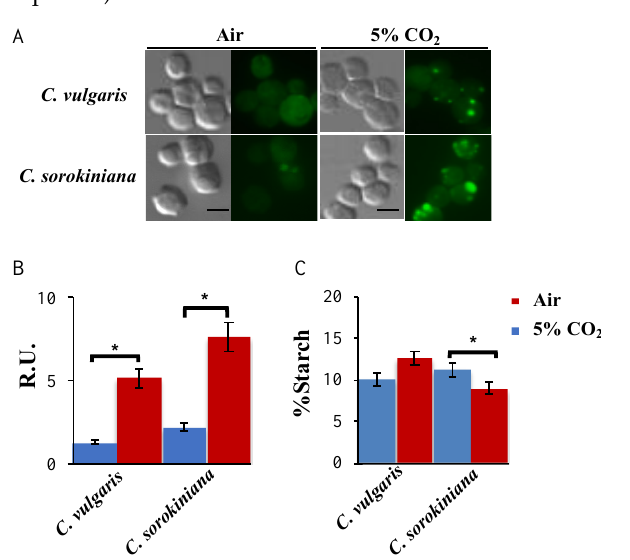
Figure 3. Carbon storage distribution in Chlorella strains: ( A ) Lipid bodies were stained with Nile red and imaged by differential interference contrast (DIC) and fluorescence microscopy in the C. sorokiniana and C. vulgaris either in air or 5% CO 2 . Scale bar = 8 mm. ( B ) Quantification of Nile red fluorescence (see Methods). R.U., relative units. ( C ) Starch levels of the reported strains under air and 5% CO 2. The mean ± SE was calculated from three independent biological replicates performed in triplicate. The measurements were performed as indicated in the Methods section. * represent significant differences ( p < 0.05) evaluated using Student’s t test.